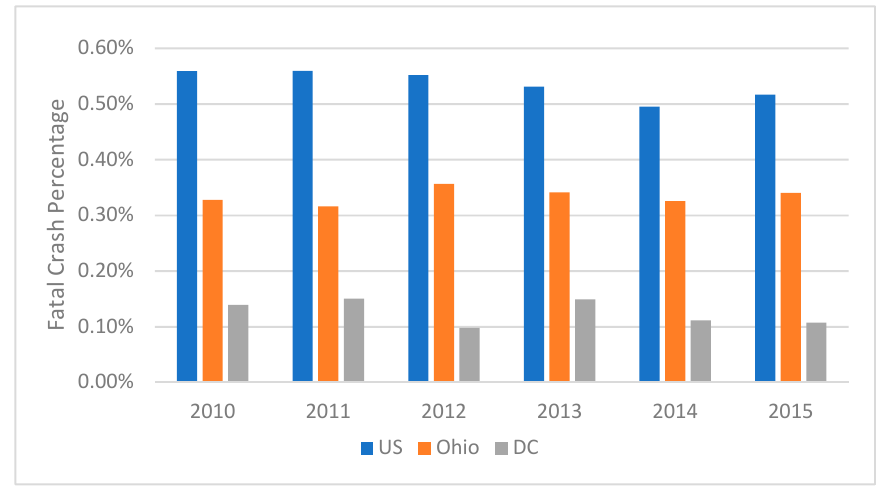
Figure 11. Crash severity relationship: fatal crash percentage.